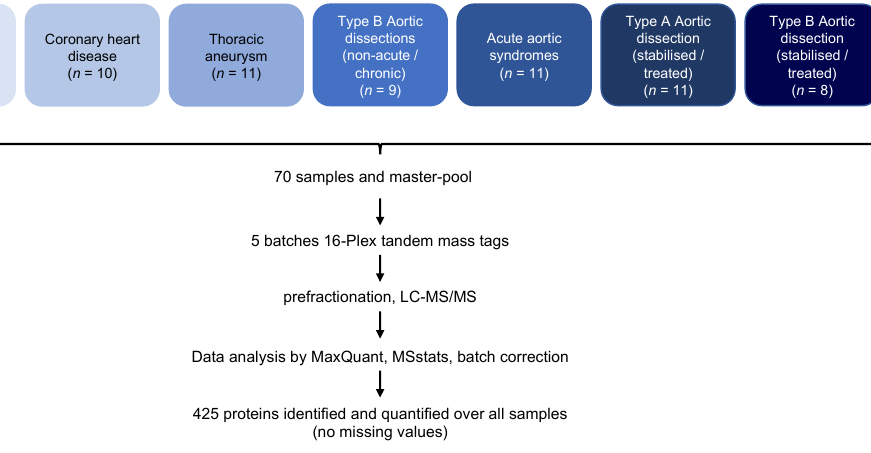
Figure 1. Overview of the proteomic workflow.